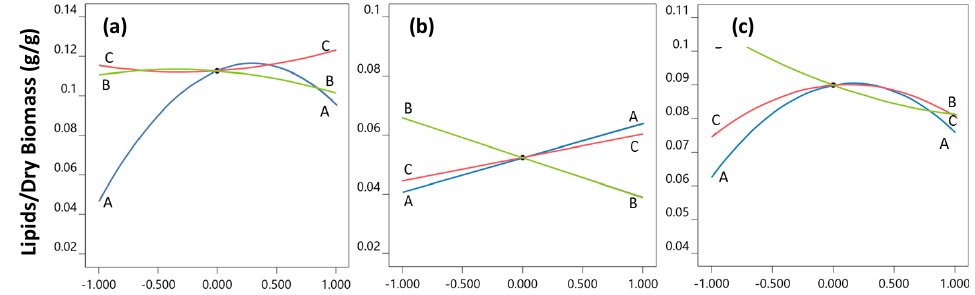
Figure 2. FCC perturbation plots for the response L/DB for all three types of solvents, ( a ) MeOH/Hex; ( b ) Isop/Hex; and ( c ) MeOH/AcOEt. A: X A , Polar/Non-polar ratio; B: X B , Vortex time; C: X C , Dry biomass/Solvent ratio.